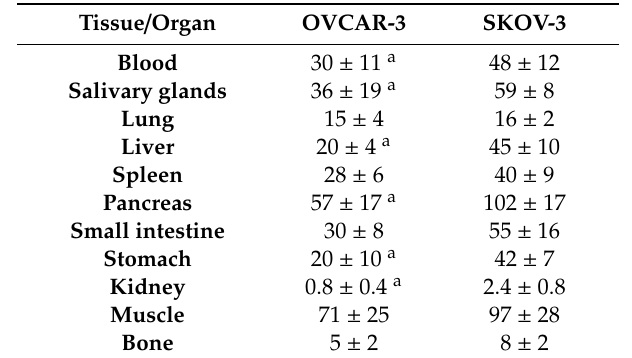
Table 2. Tumor-to-organ ratios for [ 125 I]I-PIB-Ec1 in Balb/c nu/nu mice bearing OVCAR-3 and SKOV- 3 xenografts at 6 h pi. Results are presented as average ± SD of four to six mice. a Significant ( p < 0.05) difference between OVCAR-3 and SKOV-3 groups (unpaired t -test).